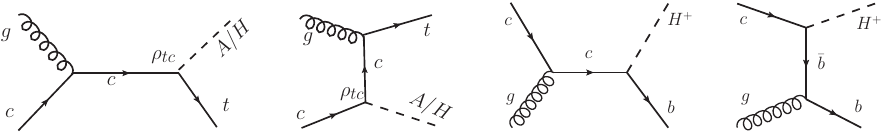
tA , tH and cg bH + associated production → →